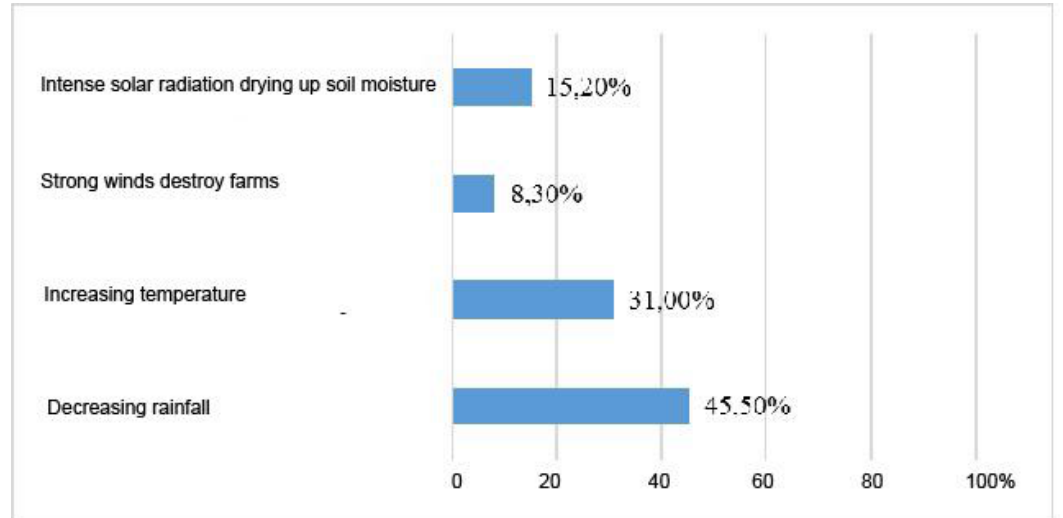
Fig. 3. Respondents’ view on climate variability and change factors influencing decisions to remove forest